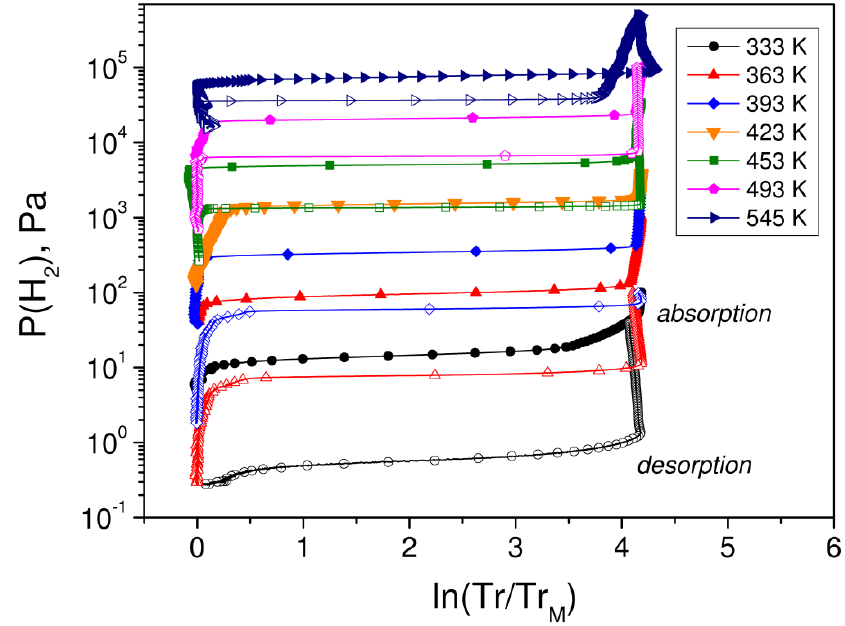
Figure 1. Pressure-transmission-isotherms of the Mg/Ta/Pd thin films during hydrogen absorption (filled symbols) and hydrogen desorption (open symbols) in a wide temperature range. Tr and Tr is the optical transmission of the films during (de-)hydrogenation and in M the metal state,